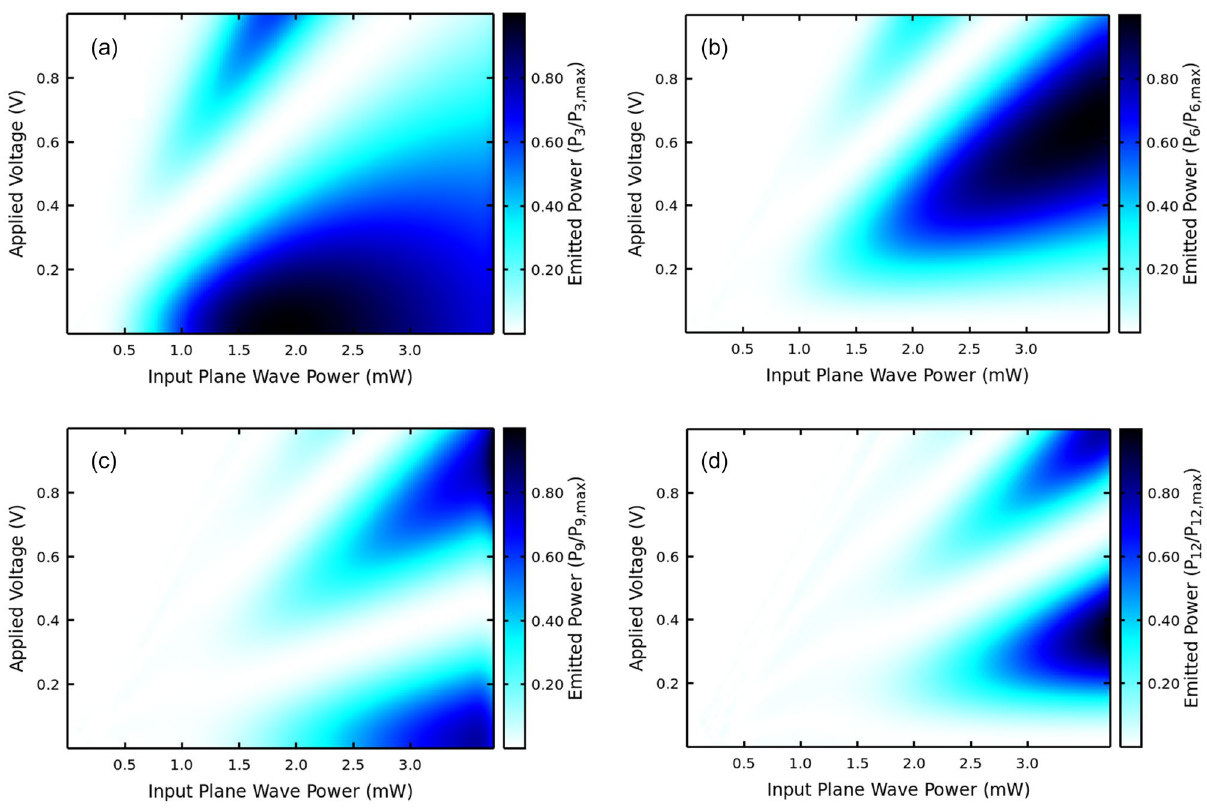
in Fig. 4, there is a 3 order of magnitude drop in output from the 3rd to the 27th harmonic. From ( a – d ) the figures correspond to the 3rd, 6th, 9th and 12th harmonics of the input frequency at 178 GHz, i.e.: 534, 712,